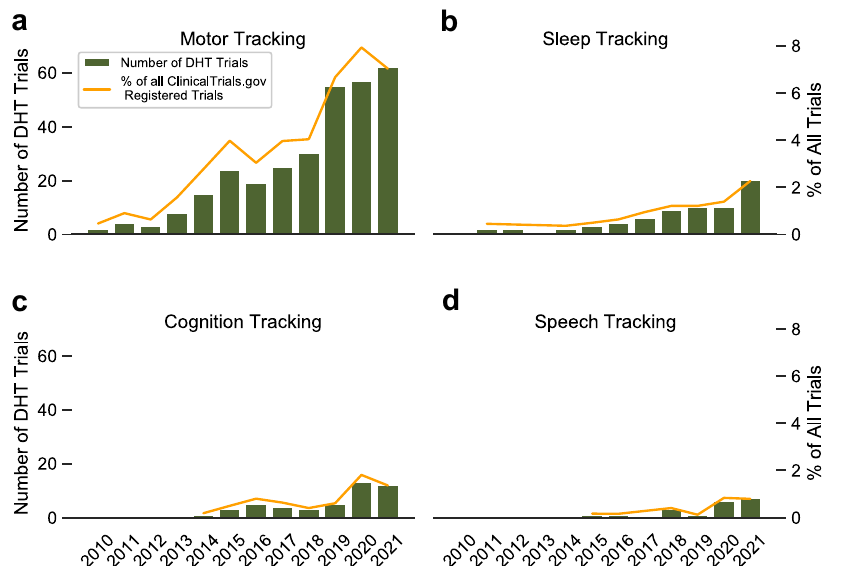
Fig. 2 Use of selected Digital Health Technology tracking modalities in trials registered on ClinicalTrials.gov for chronic neurological diseases by year of trial initiation. Number of ClinicalTrials.gov registered trials of four different neurological indications using DHTs for different tracking modalities by trial initiation year (green bar plots). Additionally, rate of these studies compared to all trials for the same indications registered on ClinicalTrials.gov for the respective year is shown (orange line). Trials for the indications epilepsy, Alzheimer ’ s disease, multiple sclerosis, and Parkinson ’ s disease were included. a Absolute number and share of all trials for motor function tracking. b Absolute number and share of all trials for sleep tracking. c Absolute number and share of all trials for cognition tracking. d Absolute number and share of all trials for speech tracking. * Data for the year 2021 may be incomplete due to late registrations on